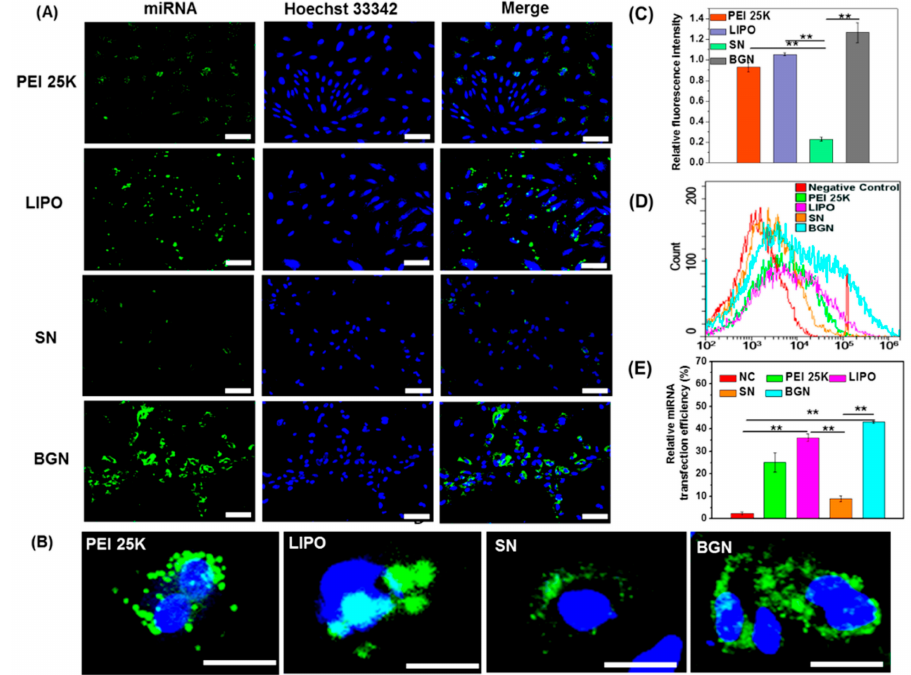
Figure 5. Transfection of FAM-labeled miRNA (0.26 mg/mL) into BMSCs with BGN (10 mg/mL), SN (10 mg/mL), and commercial PEI 25K and LIPO. ( A ) Fluorescent images of BMSCs, scale bar: 200 µ m; ( B ) Magnified fluorescent images, scale bar: 50 µ m; ( C ) Quantitative anaslysis of fluorescent signals in the cells; ( D ) Flow cytometry analysis of BMSCs; ( E ) Quantitative analysis of flow cytometry results. Adapated from reference [61] with permission. ** p <